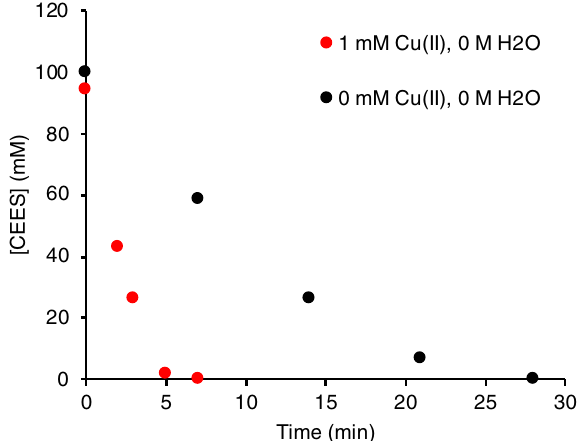
Fig. 1 Kinetics of CEES oxidation by O 2 catalyzed by Br y /NO x with and without Cu(II). Conditions: 5.0 mM TBABr 3 , 10 mM p -TsOH, 10 mM TBANO 3 , 103 mM CEES, 70 mM 1,3-dichlorobenzene (1,3-DCB) internal standard, in MeCN under 1 atm. of air at ambient temperature (~22 °C). Red curve = 1.0 mM Cu(ClO 4 ) 2 (cid:129) 6H 2 O, black curve = 0 mM Cu(ClO 4 ) 2 (cid:129) 6H 2 O. These curves represent 10 turnovers based on NO 3 − proposed complex catalytic cycle outlined in Supplementary Fig. 1. The fi rst step involves the reaction between sul fi de, CEES, and bromine to form a bromosulfonium complex that is likely a reaction intermediate. 6,26,33,34 $ R R S þ Br S þ Br þ Br (cid:2) ð 2 Þ 2 2 2 Due to the equilibrium shown in Eq. 3, tribromide solutions will contain both Br 3 − and some Br 2 and Br − with reported equilibrium constants of K = 17 and 9 × 10 6 M − 1 in water and in acetonitrile, respectively. 35 – 37 Solutions of Br 3 − and Br 2 both react with sul fi des to form the bromosulfonium intermediate (Supplementary Fig. 3). In the case of tribromide, it is generally predicted that the Br 3 − ion acts as a reservoir for Br 2 (via the equilibrium in Eq. 3), which is ultimately the reactive species toward to the sul fi de. 25 – 27 ð 3 Þ